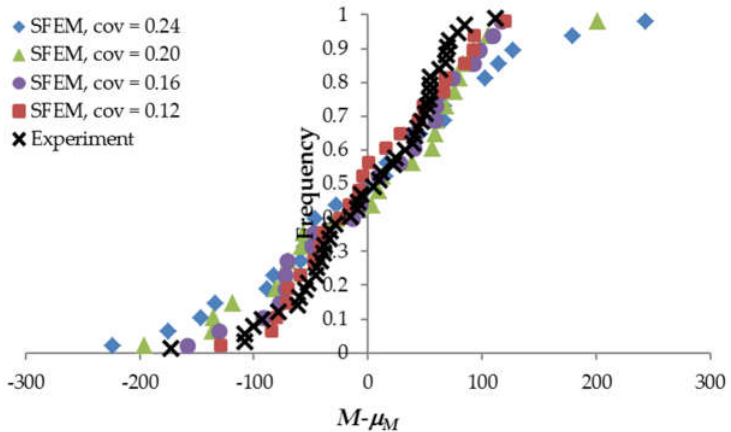
Figure 8. The translated frequency diagrams for beam LM200 obtained for different material cov compared with the experimental results of Koide et al. (Copyright Permission, Proceedings of FRAMCOS-3, 1998 and Proceedings of ICASP-8, 2000) [7,8].